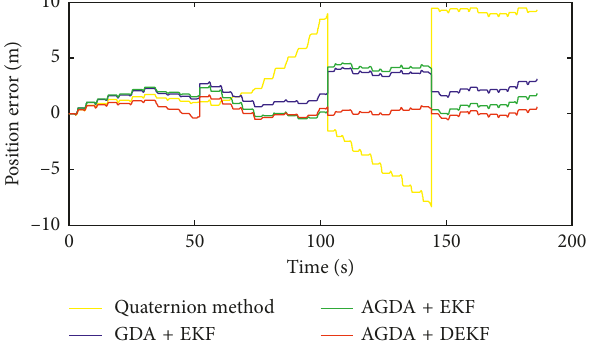
Figure 10: Position error results.